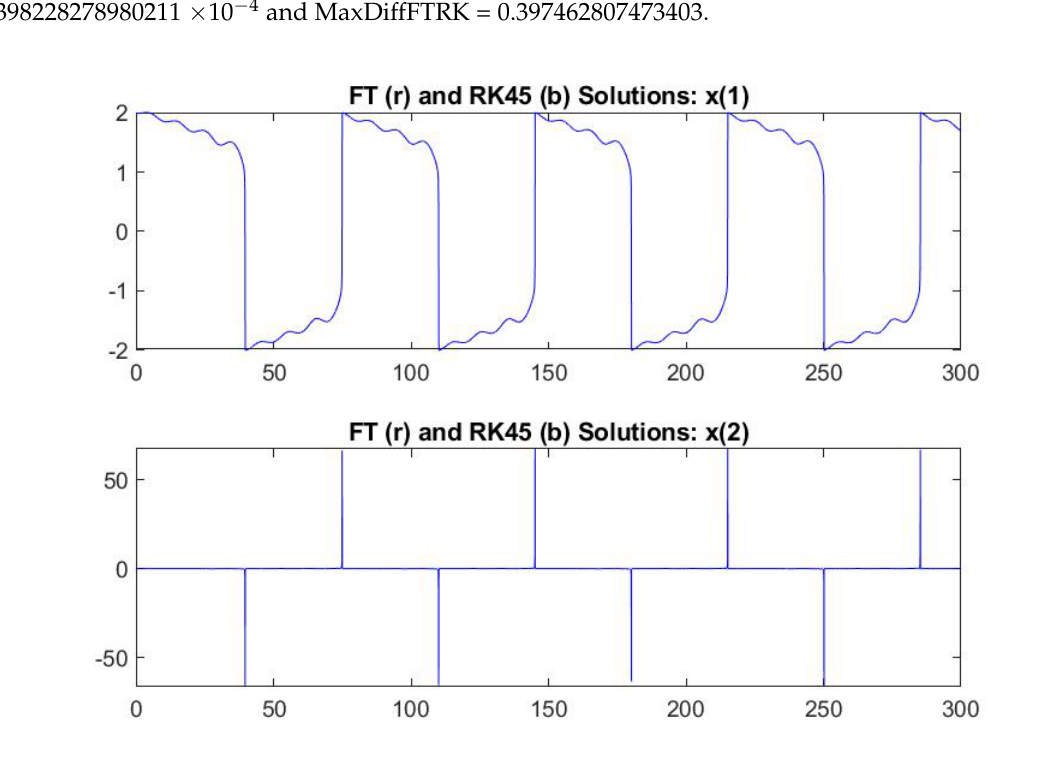
Figure 3. Problem No2 (Van der Pol): The two components x j ( t ) , j = 1,2 are displayed in the order from top to bottom; FT solution is red-colored, RK solution is blue-colored. Remark the eight jumps of the solution from positive to negative values or vice